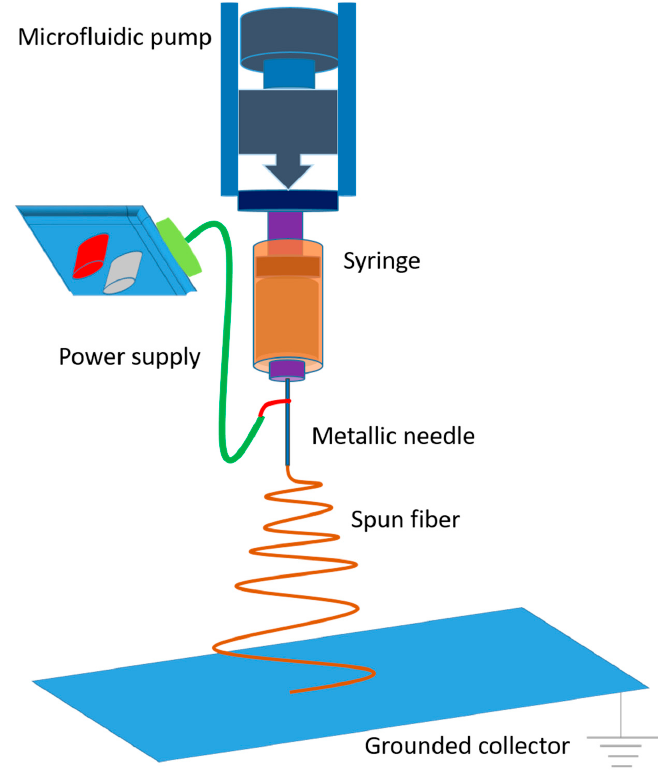
Figure 2. Electrospinning setup for fabricating nanofibers.